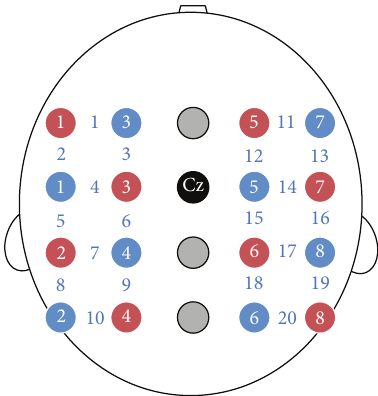
Figure 2: Configuration of NIRS channels (blue numbers) on the frontal-to-parietal areas. The eight pairs of emitting (red circles) and detecting probes (blue circles) were placed with a distance of 30 mm betweentheneighboringprobesontheholderwhichwasconfigured with a 4 × 5 array around Cz in international 10–20 system. 20 channels covered from frontal cortex to parietal